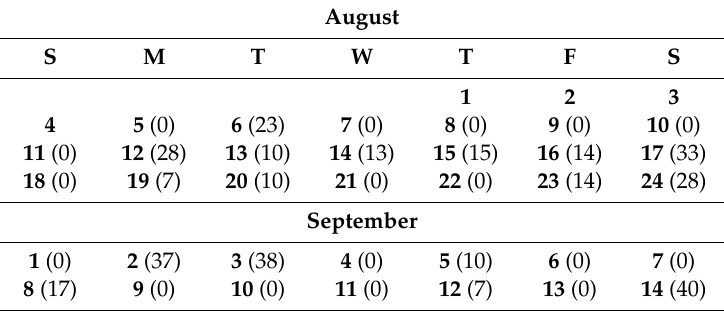
Table 3. August–September 2019 rainfall test schedule (the numbers in bold indicate the day of the month whilst the numbers in brackets give the rainfall volume (litres) applied to each PICP cell).